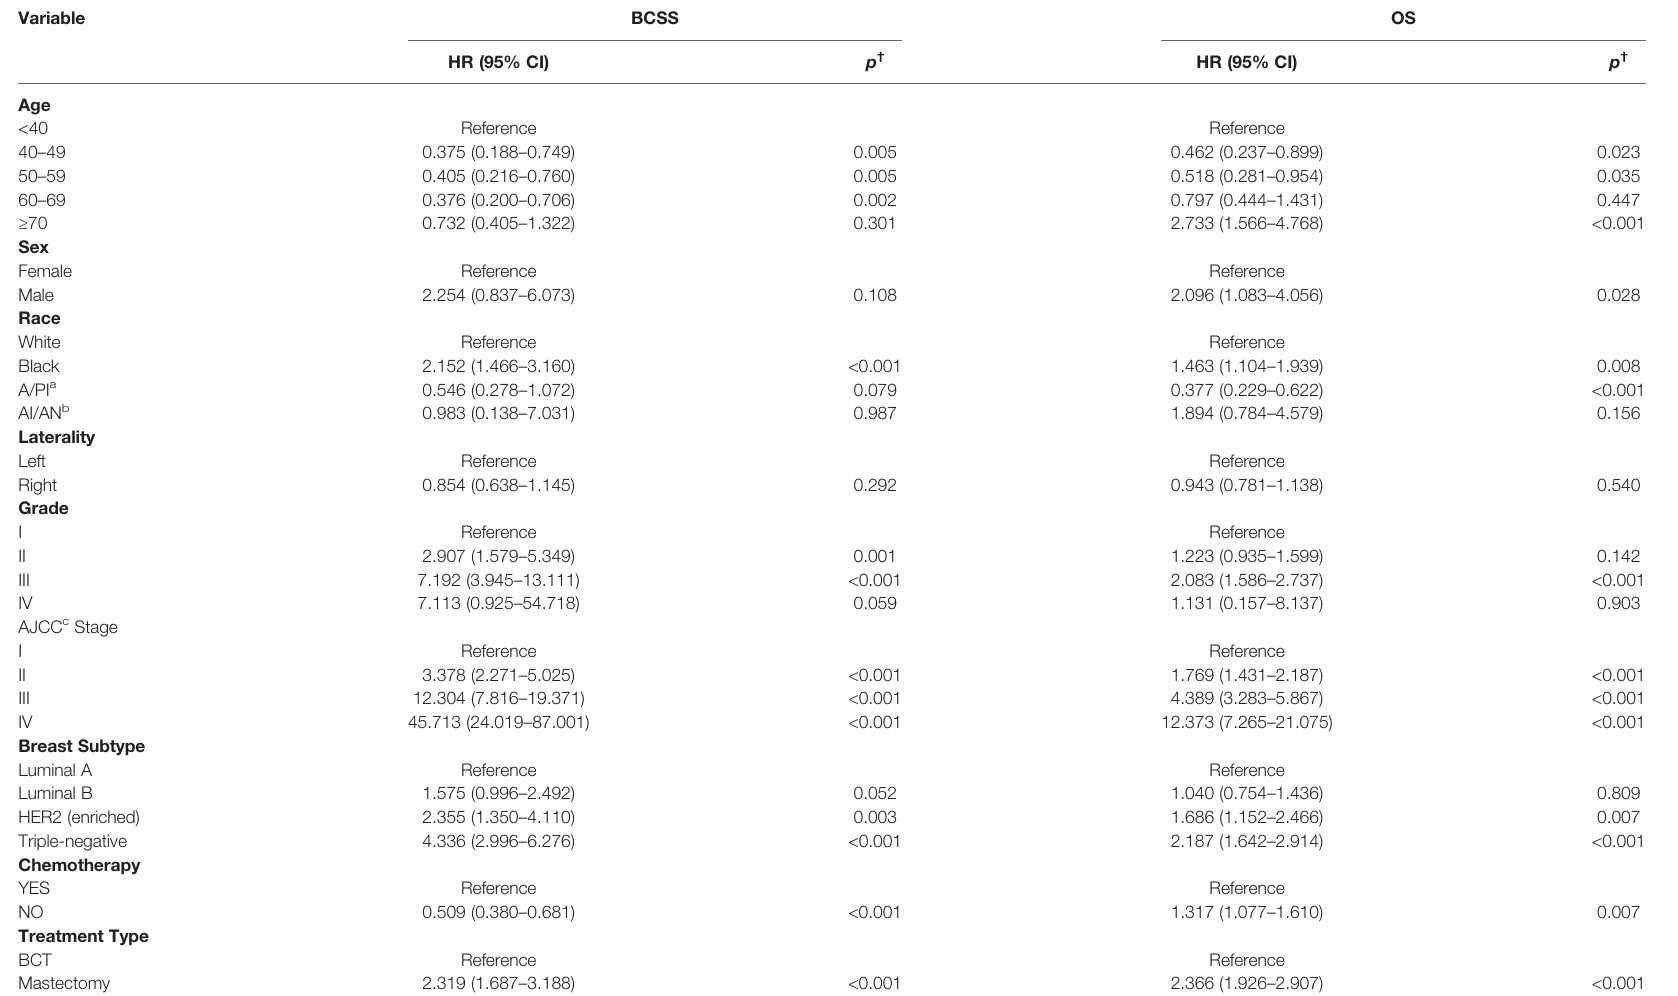
TABLE 2 | Univariable Cox proportional hazard regression model of breast cancer-speci fi c survival (BCSS) and overall survival